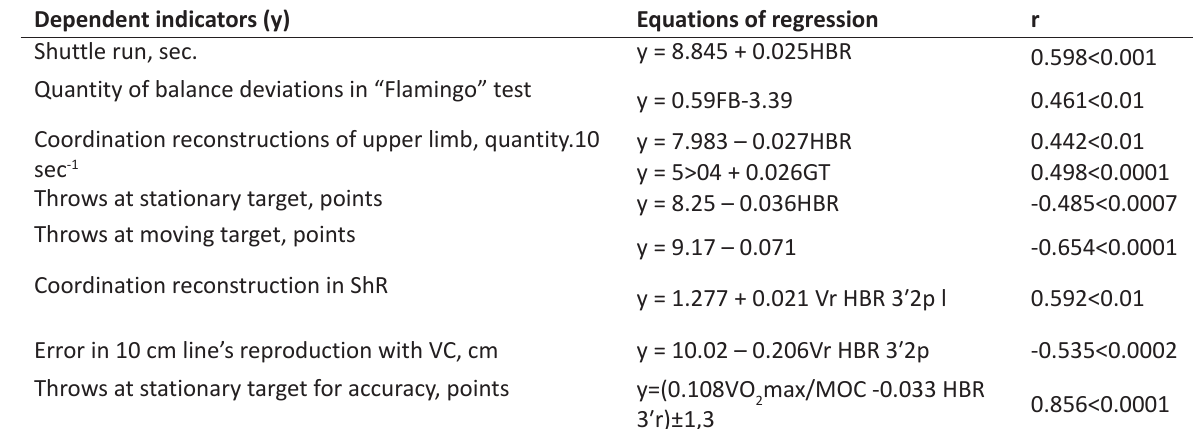
Table 2. Regression correlation models of some indicators of functional fitness and motor coordination in EG at the end of experiment Dependent indicators